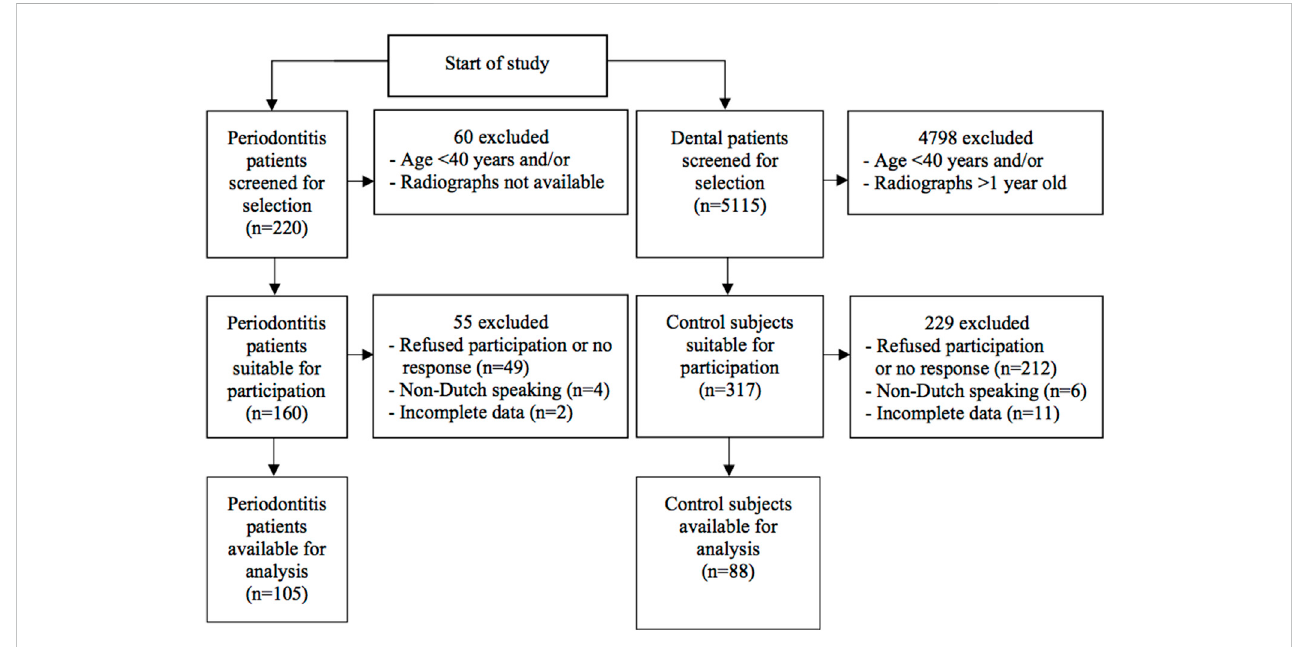
FIGURE 1 Flowchart of inclusion of periodontitis patients and control